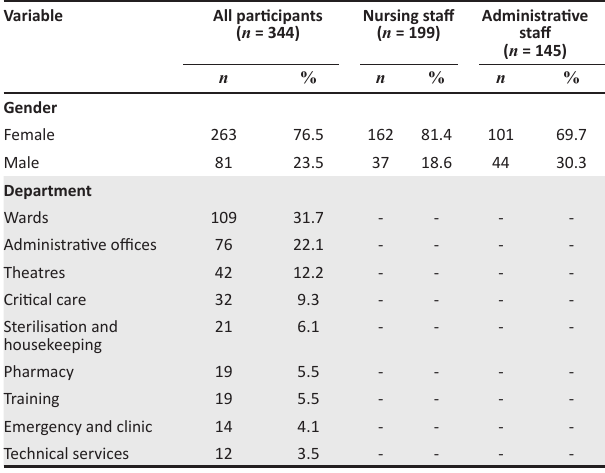
TABLE 1 : Socio-demographic information ( n = 344).